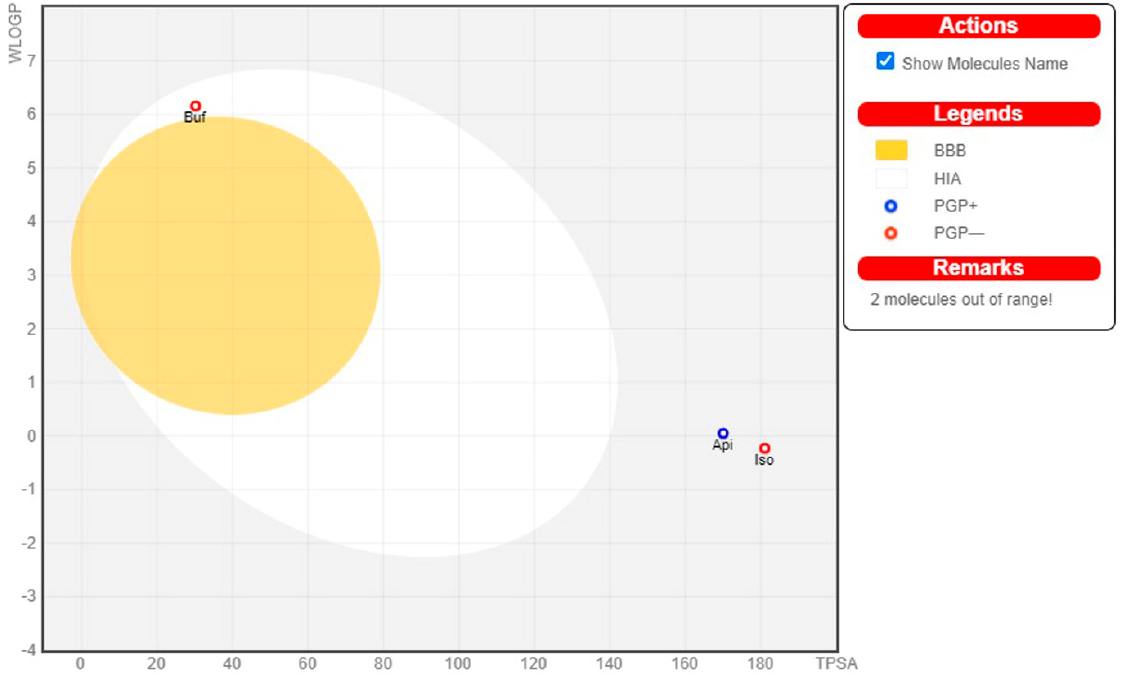
Figure 5. The egg boiled model for the top scored bioactive molecules and standard PDE5 inhibitor sildenafil. The egg boiled represents the intuitive evaluation of passive gastrointestinal absorption (HIA) as the white part and blood–brain penetration (BBB) as the yellow part, while the substrates (PGP+) and non-substrates (PGP − ) of the permeability glycoprotein (PGP) are represented by blue and red color circles, respectively, of the selected top binding scored bioactive molecules and standard PDE5 inhibitor sildenafil in the WLOGP versus TPSA graph. The grey region is the physicochemical space of compounds predicted to exhibit high intestinal absorption.